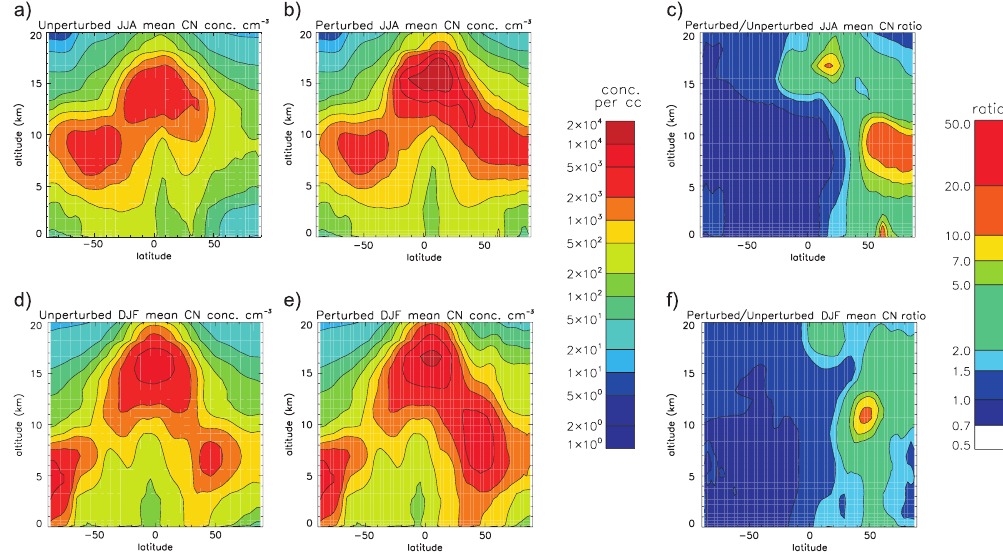
Fig. 9. Simulated zonal 3-month mean CN concentrations per cubic centimeter (per cc) for L-s: (a) unperturbed run, (b) perturbed run, (c) ratio of perturbed to unperturbed; and for L-w: (d) unperturbed run, (e) perturbed run, (f) ratio of perturbed to unperturbed. JJA=June- July-August;